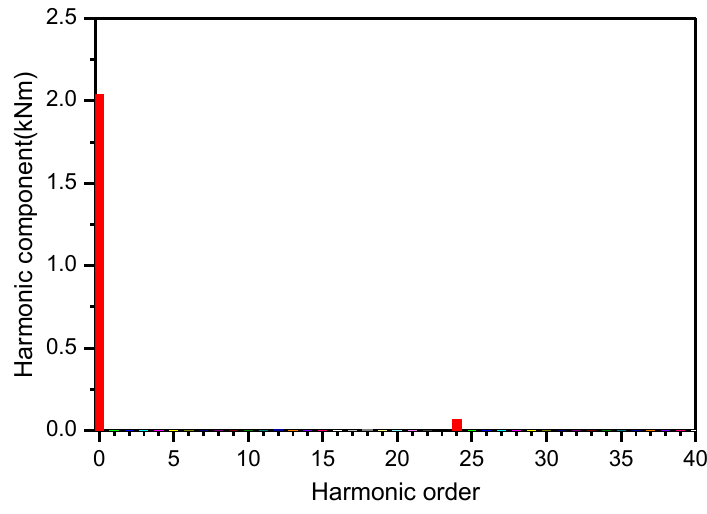
Figure 28. Harmonic analysis of the total.